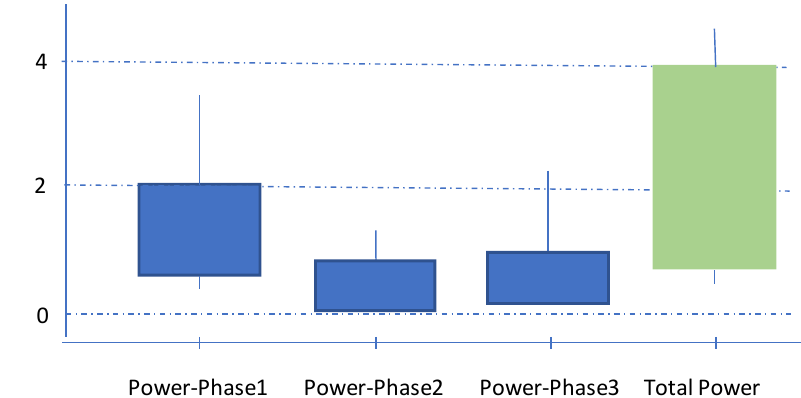
Figure 5. Power consumption for the three phases and for the total power in the monitored classroom, during the test period. Plot box represents all measurements performed.